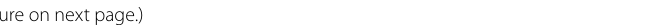
figure on next Fig. 8 Gene targets of miR-351 . A The localization and expression intensity of miR-351 in cells were detected by FISH. B The relative expression level of the ITGB3 gene in mouse aortic tissue was detected. C The relative expression level of the ITGB3 gene in the atherosclerotic cell model was detected. D The expression level of ITGB3 protein was detected by Western blotting. E The gray values of the Western blotting strips were statistically quantified. F MiR-351-5p and ITGB3 gene 3’UTR targeted binding sequence and ITGB3 gene 3’UTR mutation sequence. G Dual-luciferase activity report detection results. *P < 0.05, ITGB3 WT miR-351 mimic group vs. any group; H Western blot was used to detect the protein silencing + efficiency of ITGB3 after transfection of three siRNA groups. I Statistical quantification of H western blotting results. **P < 0.01, *P < 0.05, vs. control